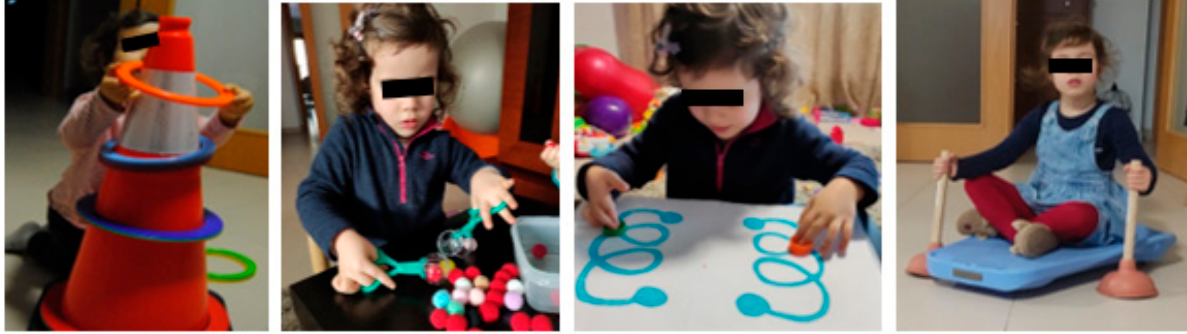
Figure 11. Bilateral integration of the injured limb.